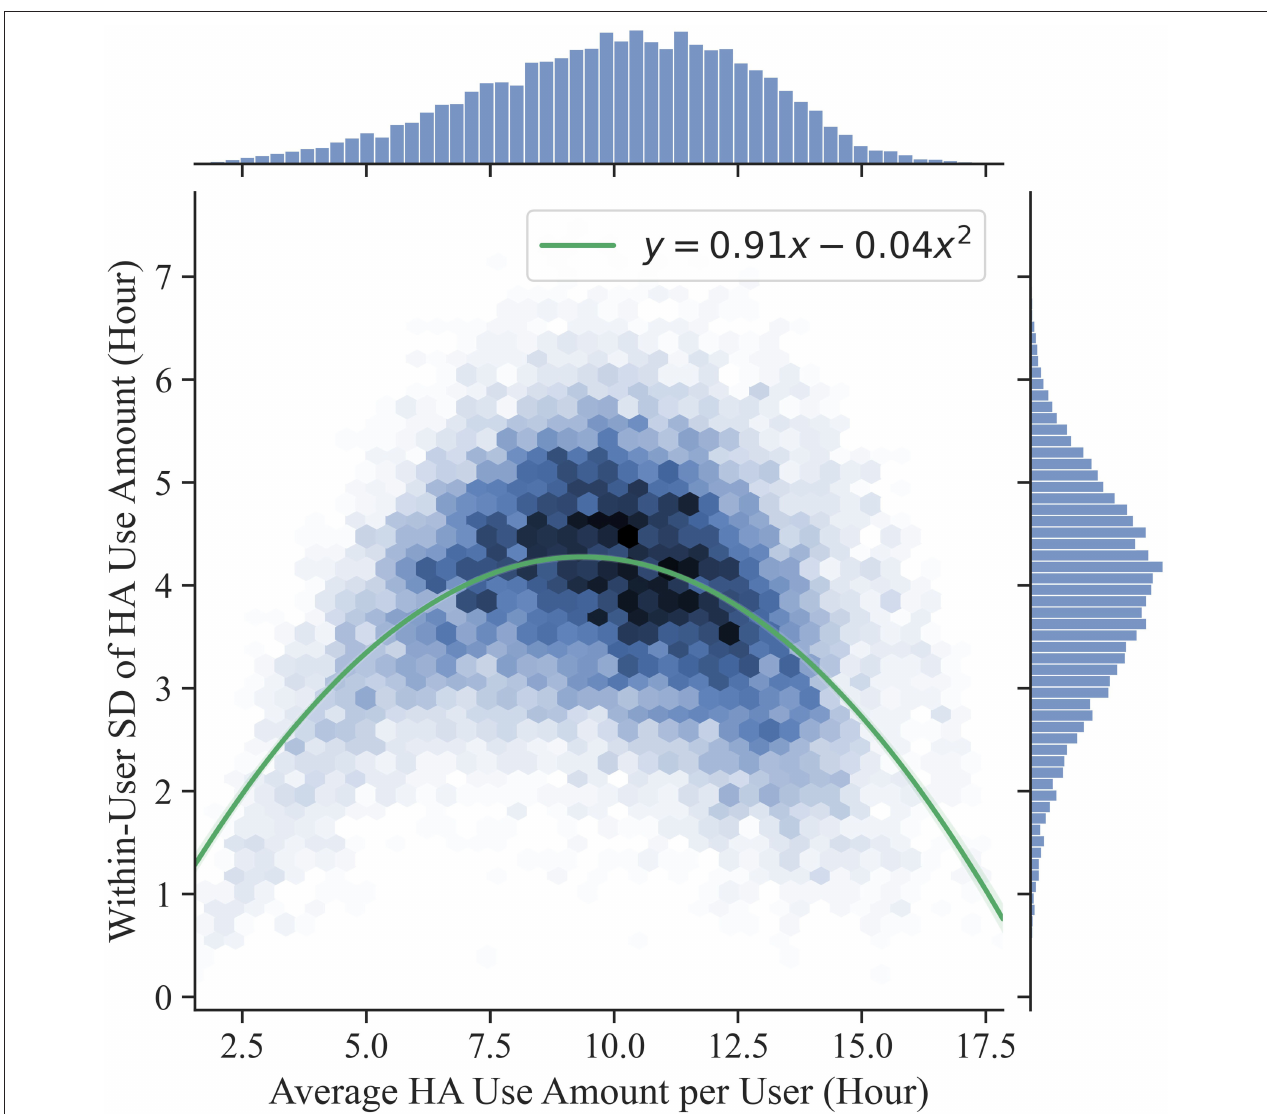
FIGURE 3 | Distribution of users by their average amount of HA use and their variability among the logged days (i.e., within-user SD). A second order linear regression model (line ± 99% confidence interval) was fitted to the data to model the relationship between average HA use (x) and within-user SD (y).